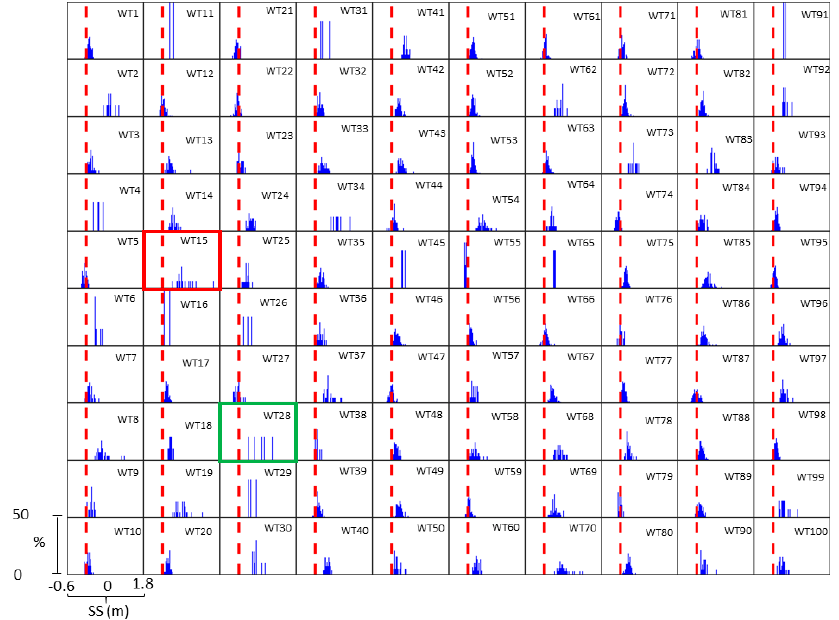
Figure A2. SD3 inferred distribution of daily maximum storm surge (SS) for each SD3 weather type (Figure A1). The dashed red line refers to a value of 0 m. Calibration period: years from 2000 to 2014, excluding 2012, which is the validation period. WT 15 and WT 28 contain the Xynthia (red rectangle) and Joachim (green rectangle) storm surge response in its associated distribution of SS.